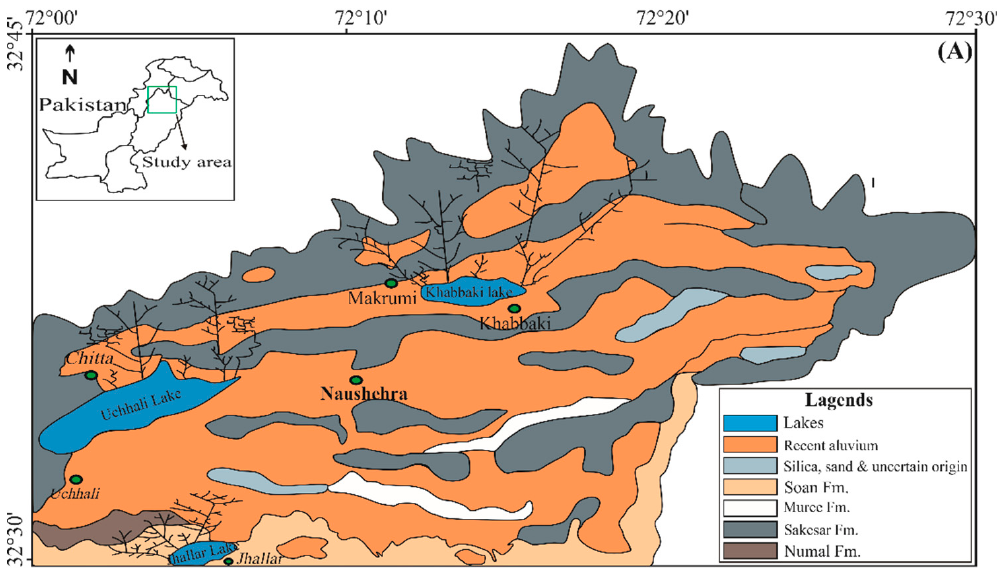
Figure 2. ( A ) Location map of the Uchhali complex, Soan–Sakesar Valley, Salt Range, Pakistan. The lithology of the study area is also reported (modified from [25,44,45]). ( B ) Stratigraphic column of the study area. The Sakesar and Muree formations represent the main water-bearing formations. 2.1. Hydrogeology and Climate Conditions Previous studies identified two major formations from the Eocene and Miocene ages as the major water resources of the Soan-Sakesar aquifer system [44,45]: the Sakesar Formation (limestone) of the Chharat group (Eocene age) is a freshwater formation and the Murree Formation of the Rawalpindi group (Miocene age) is brackish (Figure 2). Rainwater infiltration is the primary source of the groundwater (GW) recharge [25,45]. However, all three lakes are mainly fed by local rainfall, small springs, seepage from the adjacent irrigated land, and run-off from the surrounding hills of the Salt Range. The study area has a drainage pattern that is mostly dendritic (in which the streams randomly flow in all directions; Figure 2A). However, trellis (characterized by parallel main streams intersected perpendicularly, or nearly perpendicularly, by their tributaries) and rectangular patterns (a drainage pattern in which the tributaries intersect perpendicularly the main streams, and exhibit sections of approximately the same length, which form rectangular shapes) can easily be observed in the SE portion of the area. These patterns are mostly observed on Sakesar limestones due to chemical weathering. The Sakesar limestone anticlines are acting as a watershed and control the drainage system of the area [44]. Although GW pumping started in the late 1960s and peaked after 2000, it caused an added alteration of the GW flow system [14]. While percolation is the major recharge